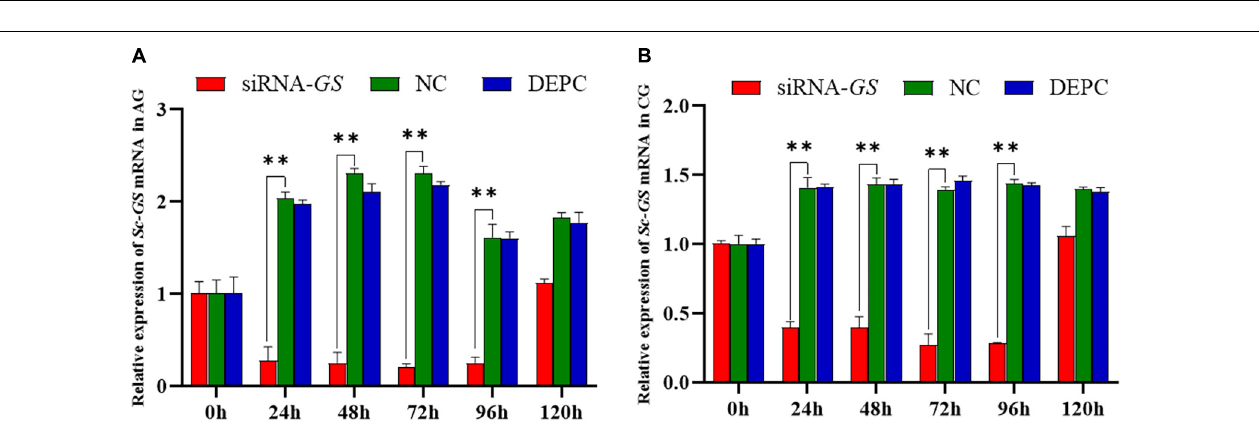
FIGURE 3 | Immunofluorescence of Sc-GS in hepatopancreas. Sc-GS protein was stained with the anti-GS antibody in green, and nuclei were stained with DAPI in blue. The merged images were colocalized with Sc-GS protein (green) and DAPI (blue) in the endothelial cells of hepatic sinusoid. Scale bars were 50 µ m.